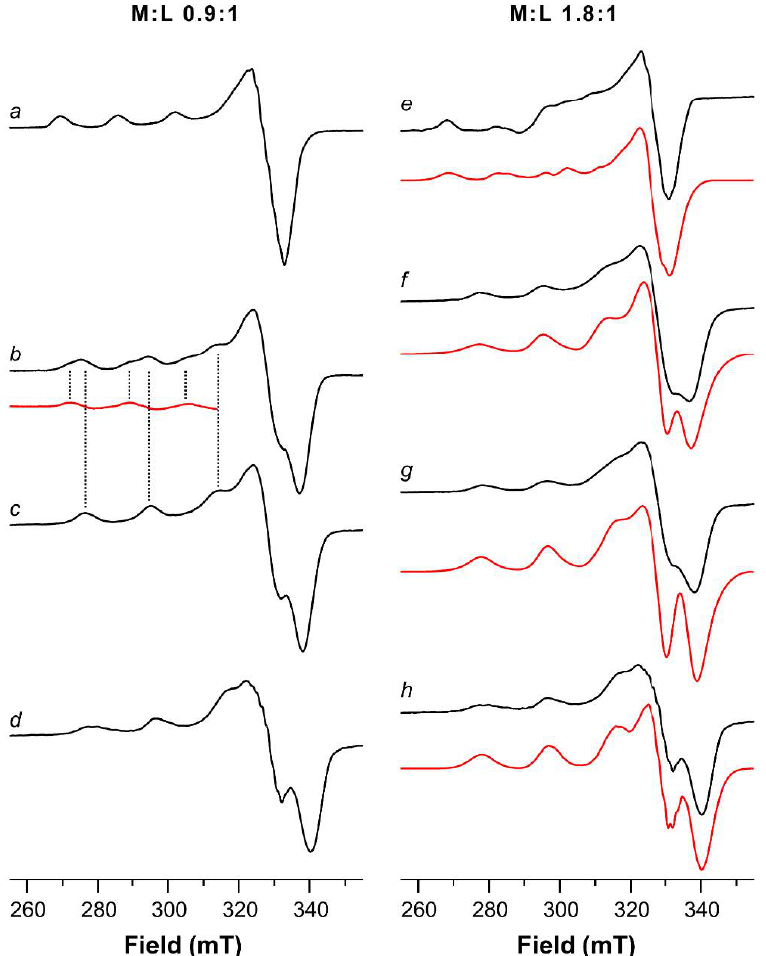
Figure 4. ESR spectra at 150 K of 63 Cu(II)-AcAng1-17 system ( a – d , M:L 0.9:1) and 63 Cu(II)-AcAng1- 17 system ( e – h , M:L 1.8:1) in aqueous solution as function of the pH: ( a ) 5.0; ( b ) 6.0 (the red trace represents the parallel features of the spectrum of trace at pH 6.0 minus trace at pH 6.9); ( c ) 6.9; ( d ) 10.8; ( e ) 4.3 (subtracted from [ 63 Cu(H 2 O) 6 ] 2+ features); ( f ) 6.4; ( g ) 7.6; ( h ) 10.8. Simulated spectra on the right panel are shown by the red